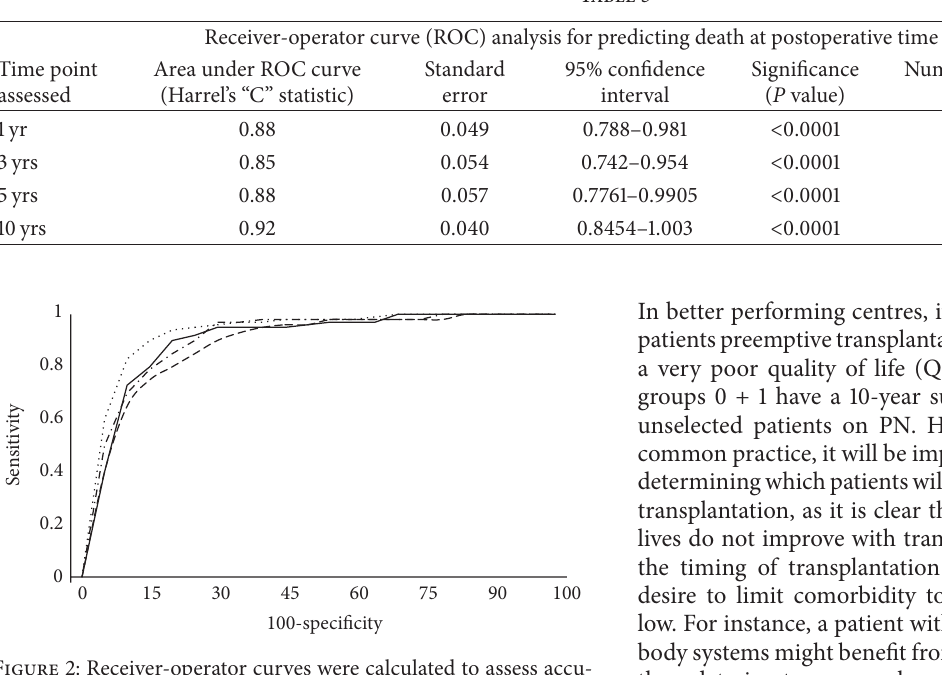
Figure 2: Receiver-operator curves were calculated to assess accu- racy of survival prediction at 1, 3, 5, and 10 years postoperative (continuous line, dashed line, dashed/dotted line, and dotted line, resp.). The accuracy of the comorbidity score is indicated by the area under the curve (Harrell’s “C” statistic) and was very good or excellent for predictions at each time frame with associated “C” statistics of 0.88, 0.85, 0.88, and 0.92,